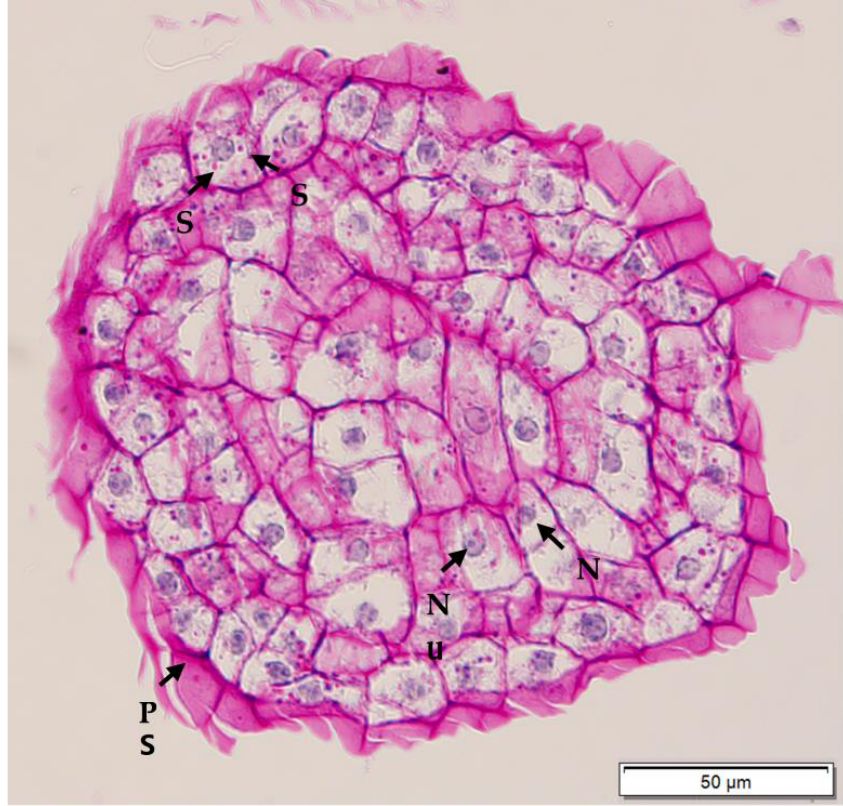
Figure 10. Histological section of compact embryogenic callus derived from a plumule obtained from a CAIRNS embryo, and after periodic acid Schiff’s staining. Nuclei were stained blue, while starch and polysaccharidic sheath (PS) were stained pink or purple. Numerous starch (S) granules are observed surrounding the large nucleus (N) with visible nucleolus (Nu).